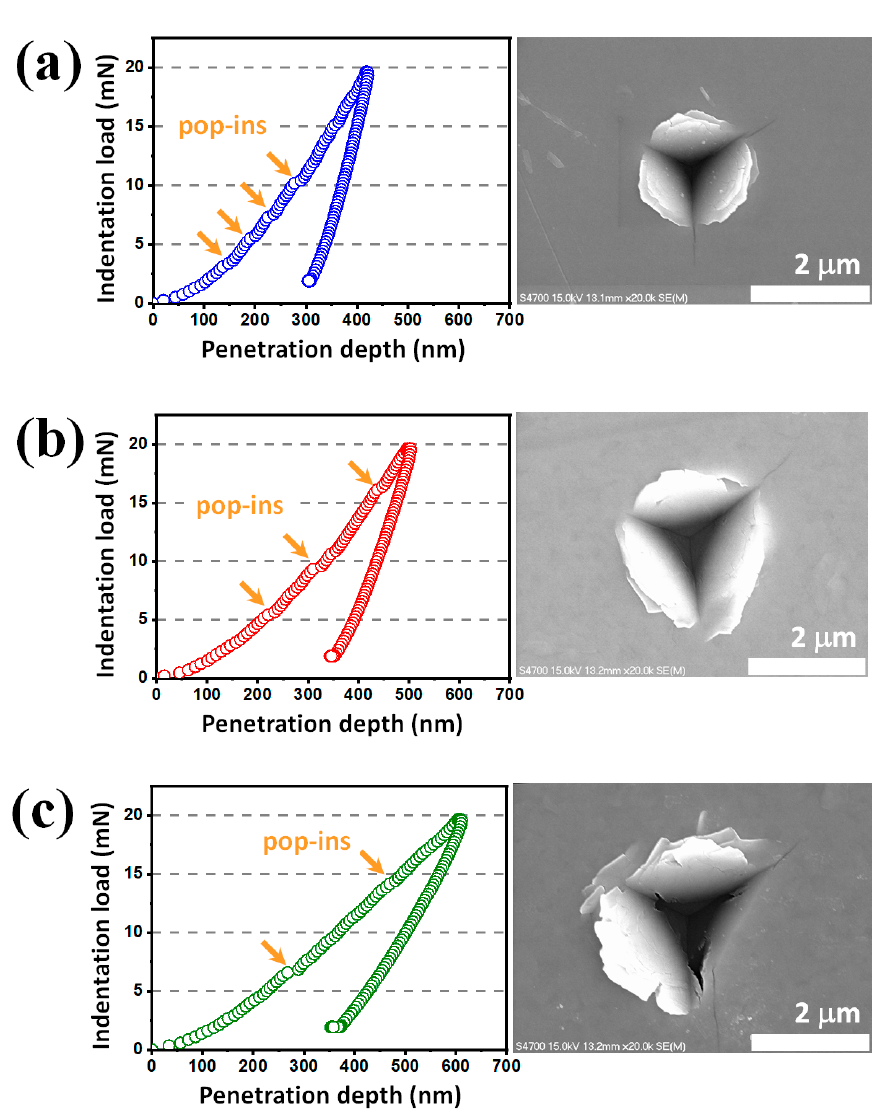
Figure 6. Berkovich nanoindentation on the Bi 2 Te 3 thin films at various T S : ( a ) 225 ◦ C, ( b ) 250 ◦ C, and ( c ) 300 ◦ C. The corresponding SEM indentations are displayed to the right of the load-depth curves.